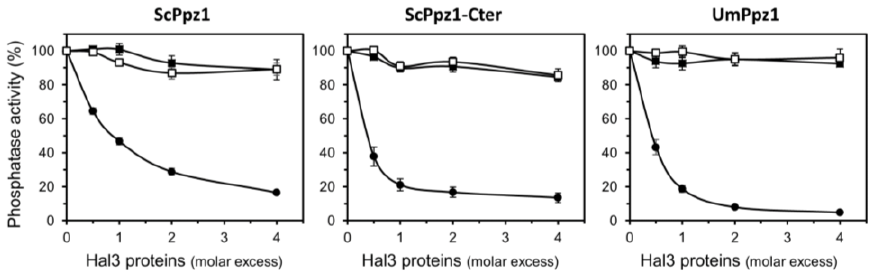
Figure 4. Inhibitory capacity of different UmHal3 versions on ScPpz1 and UmPpz1. Five to ten pmols of ScPpz1, ScPpz1-Cter, or UmPpz1 were pre-incubated for 5 min at 30°C with different amounts of ScHal3 (- -), UmHal3_PD (- -) or UmHal3-ScCt ( - - ), and the assay was initiated by addition of the substrate. Data are means ± S.E. from 4 to 7 different assays and correspond to the ratio of phosphatase activity in the presence and the absence of inhibitor, expressed as percentage. Two different preparations of the phosphatases and the inhibitors were tested.